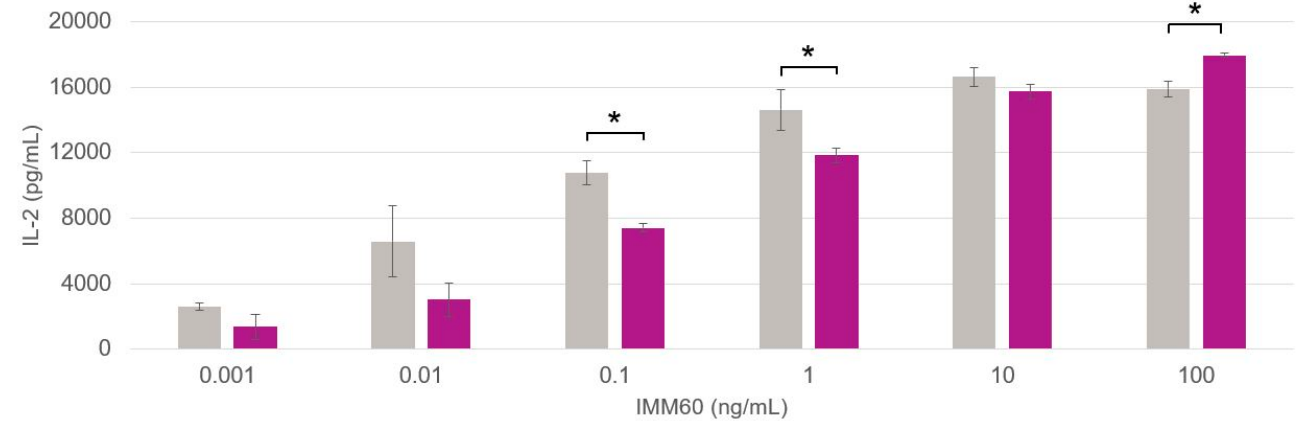
Figure 4. Differences in IL-2 production by mouse iNKT cells with respect to the particle production method. Average data points are acquired from the curves of peptide 1, peptide 2 and peptide 3 responses pooled together. Data obtained from particles generated at the lab -scale and industrial scale are depicted in grey and purple, respectively. (*) Significant p < 0.05.